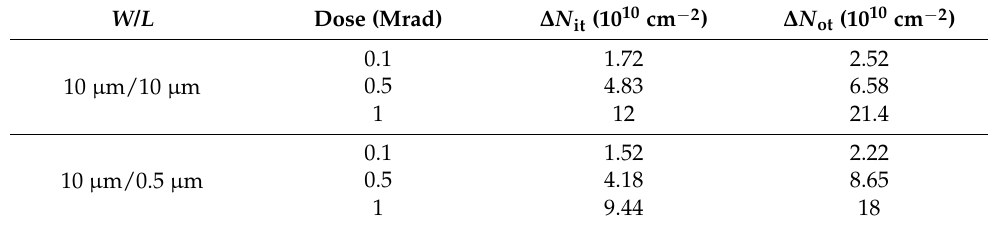
Table 2. ∆ N it and ∆ N ot of devices in Figure